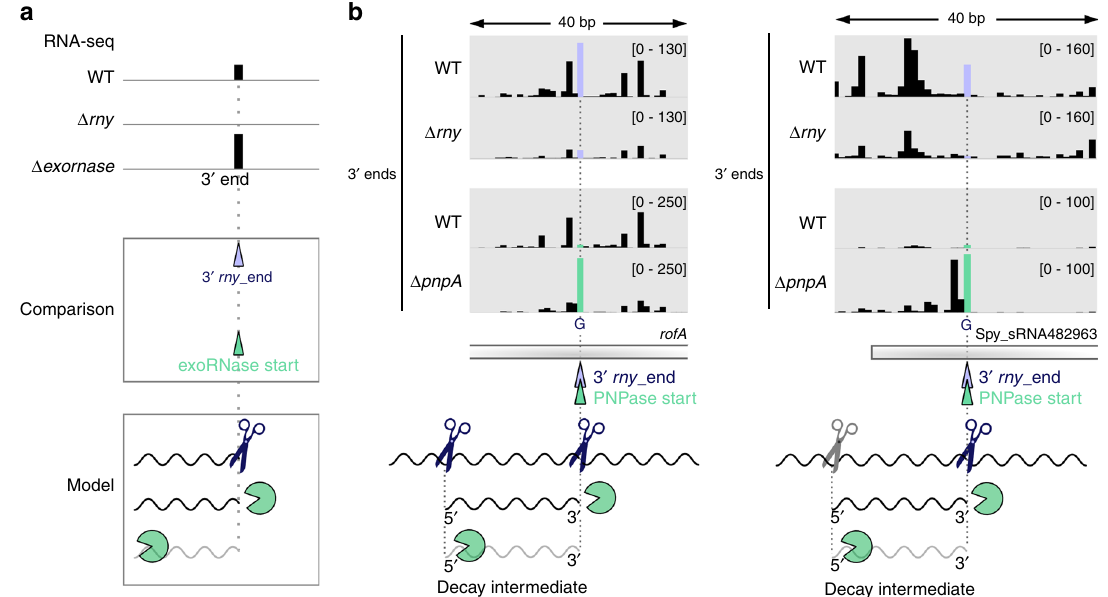
Fig. 4 Initial RNase Y cleavage position validated by PNPase trimming start positions. a Upper panel: example of 3 ′ end coverage pro fi ling from RNA sequencing. Middle panel: the RNA ends that were more abundant in the WT than in the Δ rny strain are indicated below the coverage and depicted with purple arrowheads (3 ′ rny _ends). The RNA ends corresponding to the trimming start positions of exoRNases are depicted with green arrowheads (see